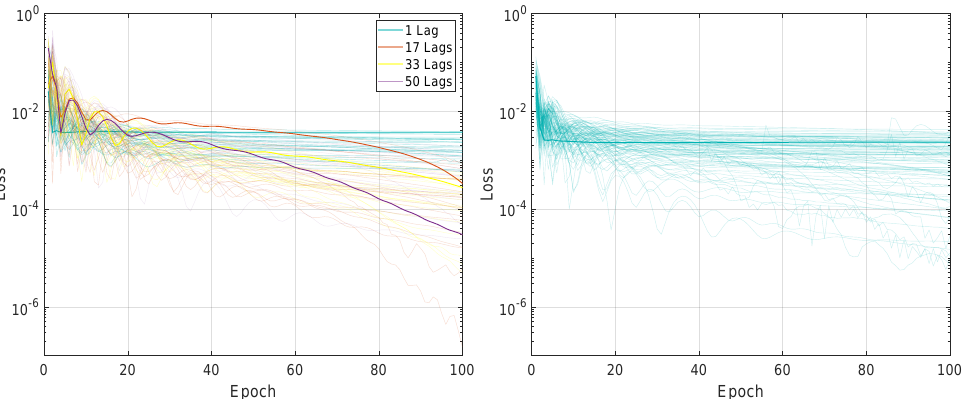
Figure 3. Illustration of the training loss for Experiment 1, LSTMTF ( left ) and VLSTM ( right ), using a many-to-one prediction mode. For each architecture, the lines with the same colors represent the loss for networks trained with the sequence length in the range [1:500]. The highlighted thick lines represent the training loss for a sequence length of 1.